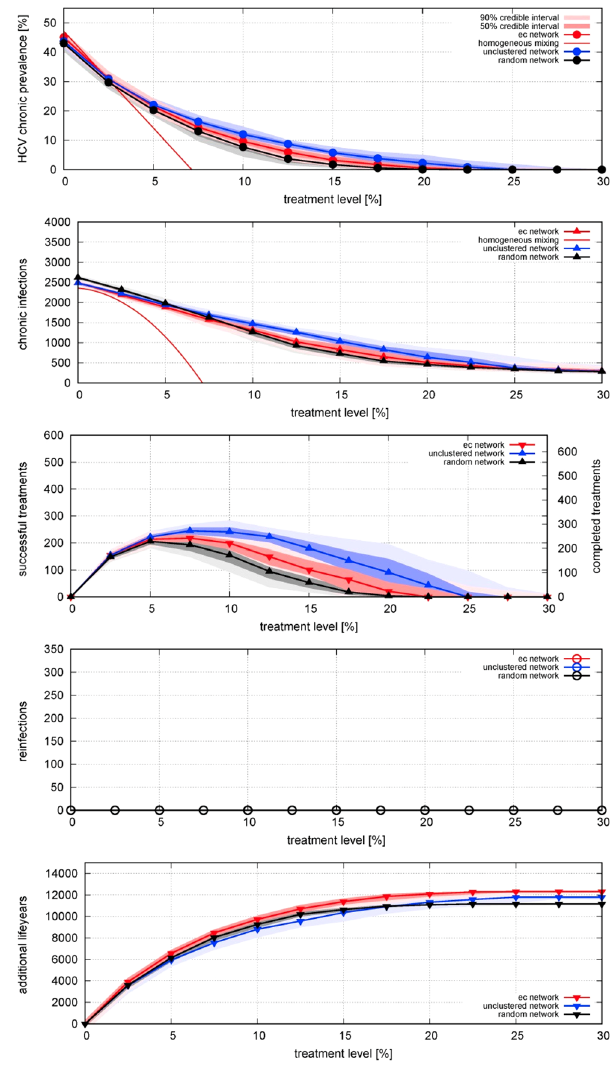
Figure 4. Effect of different treatment rates on equilibrium ( A ) prevalence of HCV infection; incidence per year of ( B ) chronic infection, ( C ) cured by successful treatment, ( D ) reinfection – which is always zero in this scenario because cured individuals change their behaviour to eliminate their reinfection risk; and ( E ) life-years gained; for three different network structures, for treatment rates varied from 0 to 30% per year, with behaviour- change post-treatment preventing reinfection. Points indicate median results and shading represents the 50% range (i.e. inter-quartile range) and 90% ranges of 100 model realizations of a network with 1000 PWID over a time period of 20 years (i.e. turnover of 50 people entering and exiting per year). For prevalence and incidence, the behaviour of the homogeneous-mixing model is also shown: as it is a deterministic model there is no range of